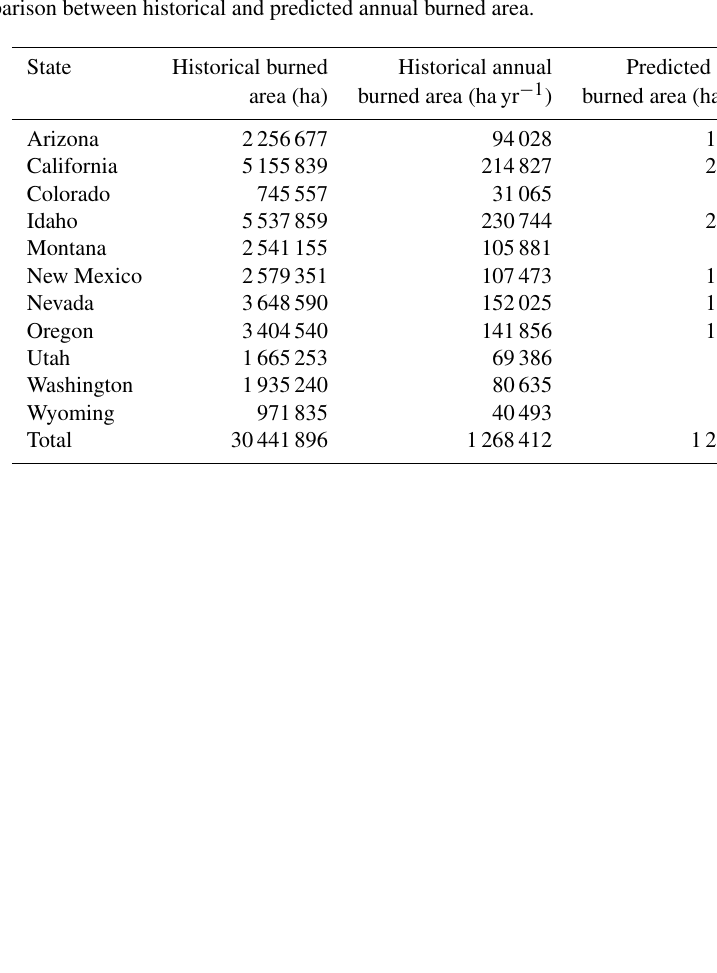
Table B2. Per state comparison between historical and predicted annual burned